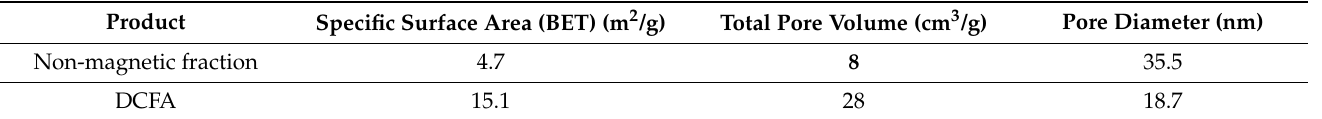
Table 3. The BET analysis of the non-magnetic fraction and the DCFA after NaOH leaching at T = 110 ◦ C, L/S ratio = 10, τ = 25